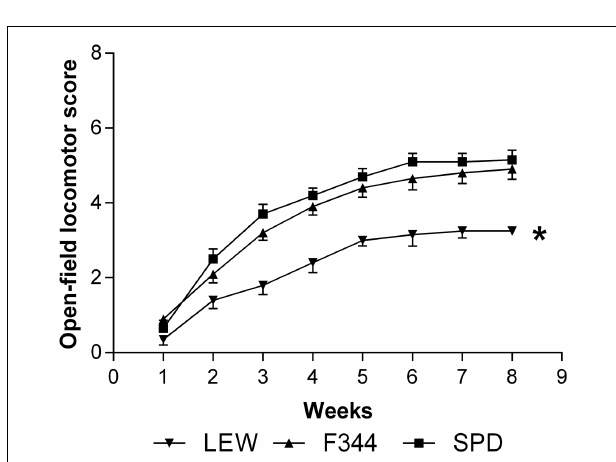
FIGURE 3 | Motor recovery of Lewis (LEW), Fischer 344 (F344), and Sprague-Dawley (SPD) rats subjected to SCI . BBB score showed a significant improvement in F344 and SPD as compared to LEW rats. * P < 0.001. Repeated measures two-way ANOVA with Bonferroni’s post hoc test. Data of 10 rats per group.